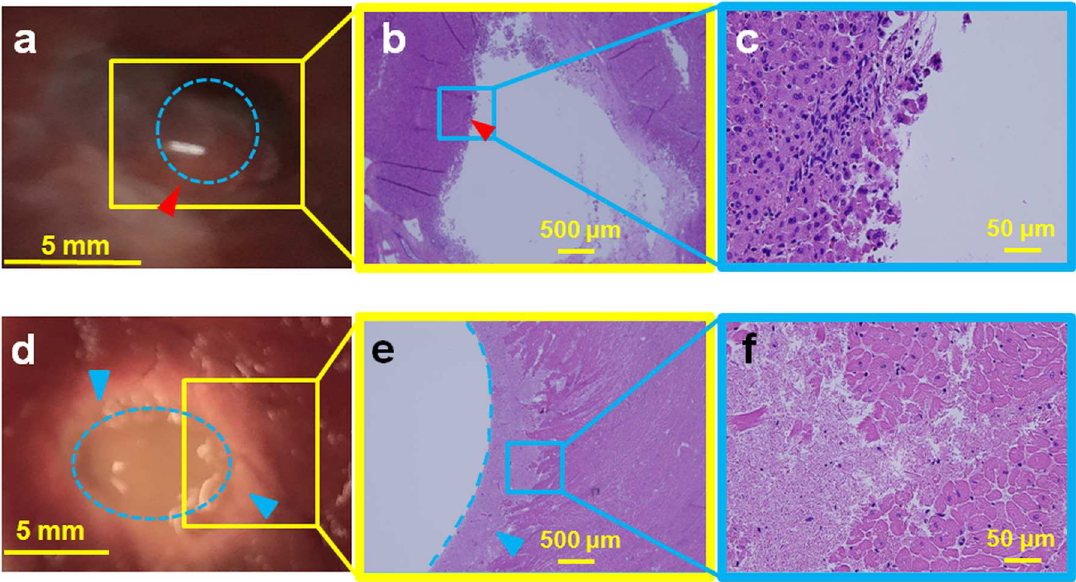
Fig 9. Ex vivo porcine liver (top panel) and cardiac muscle (bottom panel) sonicated at 600 W acoustic power at 1 Hz PRF and 20,000 cycles/pulse. a . Gross pathologyof the liver tissue with the lesion in the center (red arrowhead), showing minimalthermal damage with a liquefiedcentral void (blue dotted circle). b . H&E slide showingthe entire lesion with sharp boundaries (red arrowhead). c . Magnification (4X) of the Fig 9b, presenting intact cell structures at the peripheryof the lesion. d . Gross pathologyof the cardiactissue with a large void in the center (blue dotted oval). A concentric ring of necrosis (blue arrowheads) surroundsthe central void. e . H&E slide, with the void outlinedby the blue dotted line and the blue arrowhead pointing to the regionof necrosis. f . Magnifiedimage (40X) of Fig 9e show regions of both necrosis and intact cellular structures.